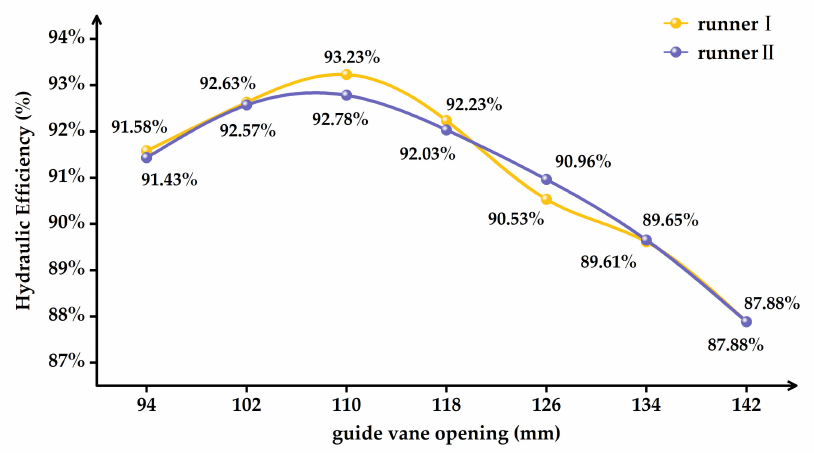
Figure 5. Relationship curve between hydraulic efficiency and guide vane